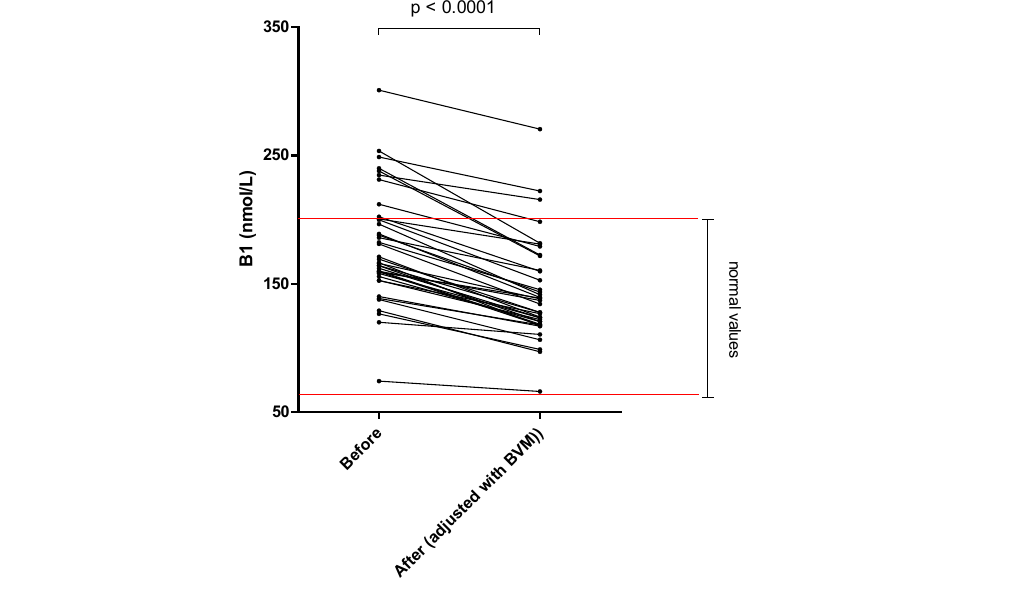
Figure 1. Vitamin B1 (thiamine pyrophosphate) blood concentration before and after one 4 h-HDF session (paired t- test).